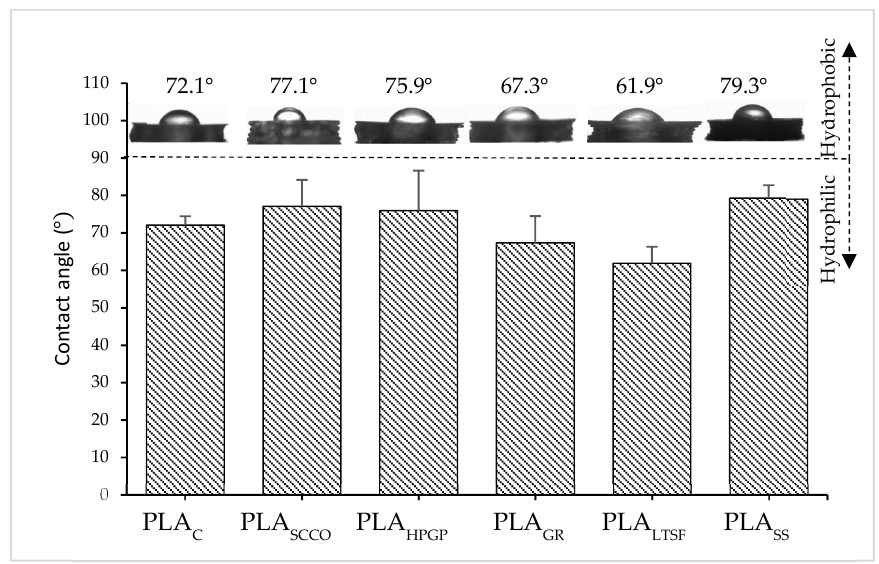
Figure 6. Modulus and hardness of PLA discs subjected to the different sterilisation treatments: PLA GR , PLA SCCO , PLA LTSF , PLA SS and PLA HPGP together with the untreated PLA disc as control, PLA C . Results are presented as mean ± standard deviation.